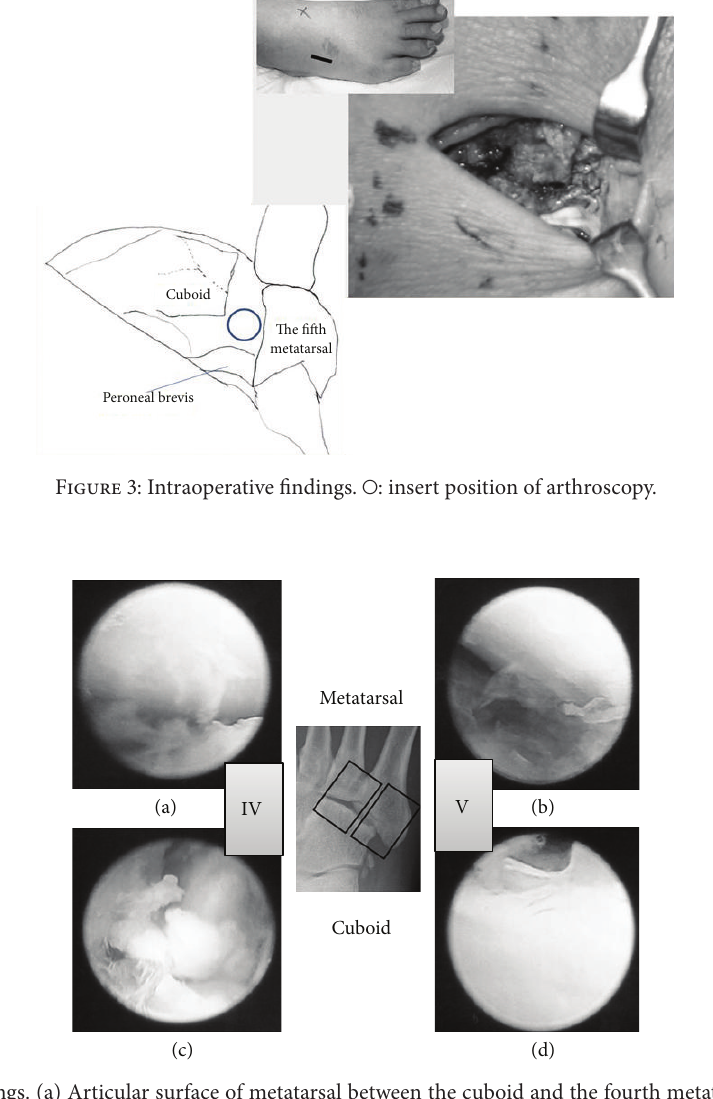
Figure 4: Arthroscopic findings. (a) Articular surface of metatarsal between the cuboid and the fourth metatarsal. (b) Articular surface of metatarsal between the cuboid and the fifth metatarsal. (c) Articular surface of cuboid between the cuboid and the fourth metatarsal. (d) Articular surface of cuboid between the cuboid and the fifth